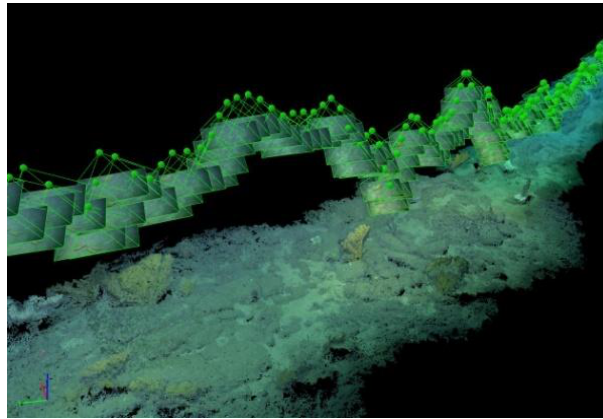
Figure 3. Example of 3D point cloud reconstruction of video transect.